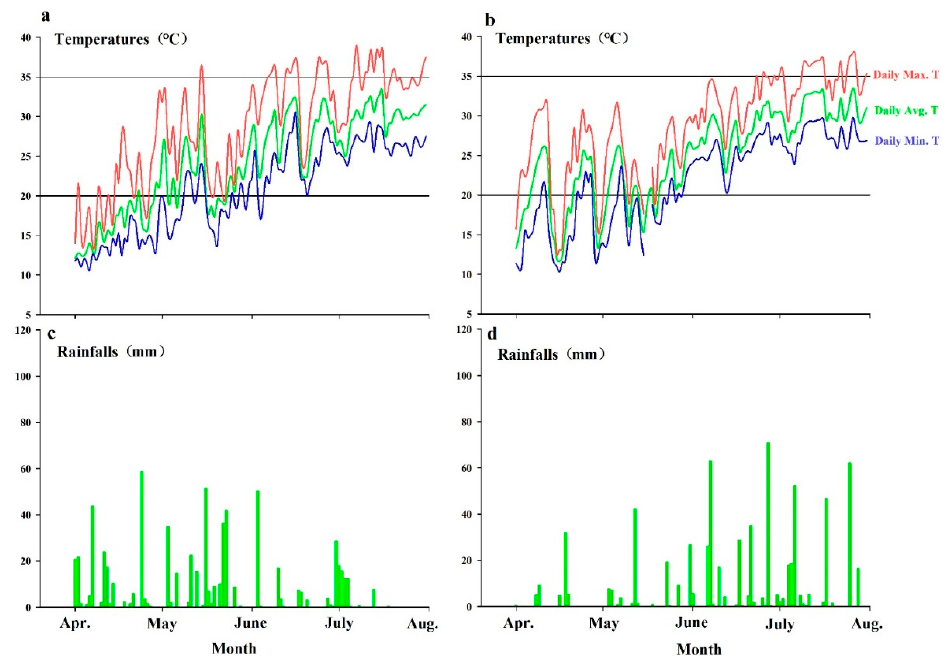
Figure 3. Temperature (daily maximum, daily average and daily minimum) and rainfall during the rice-growing season at the experimental sites in 2021 ( a , c ); and 2022 ( b , d